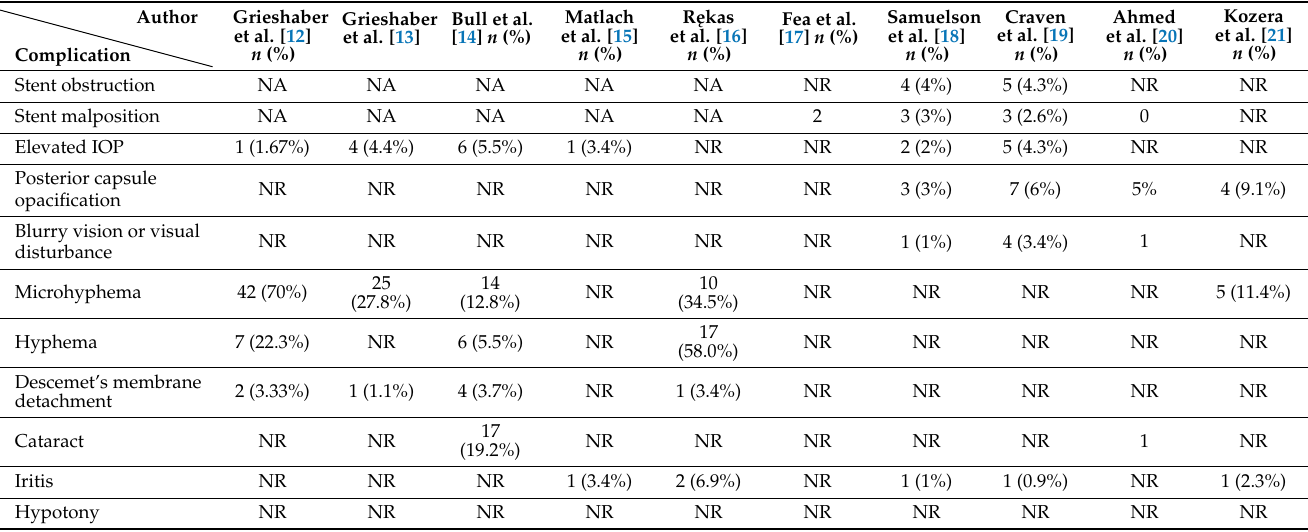
Table 4. Main postoperative complications after canaloplasty and iStent